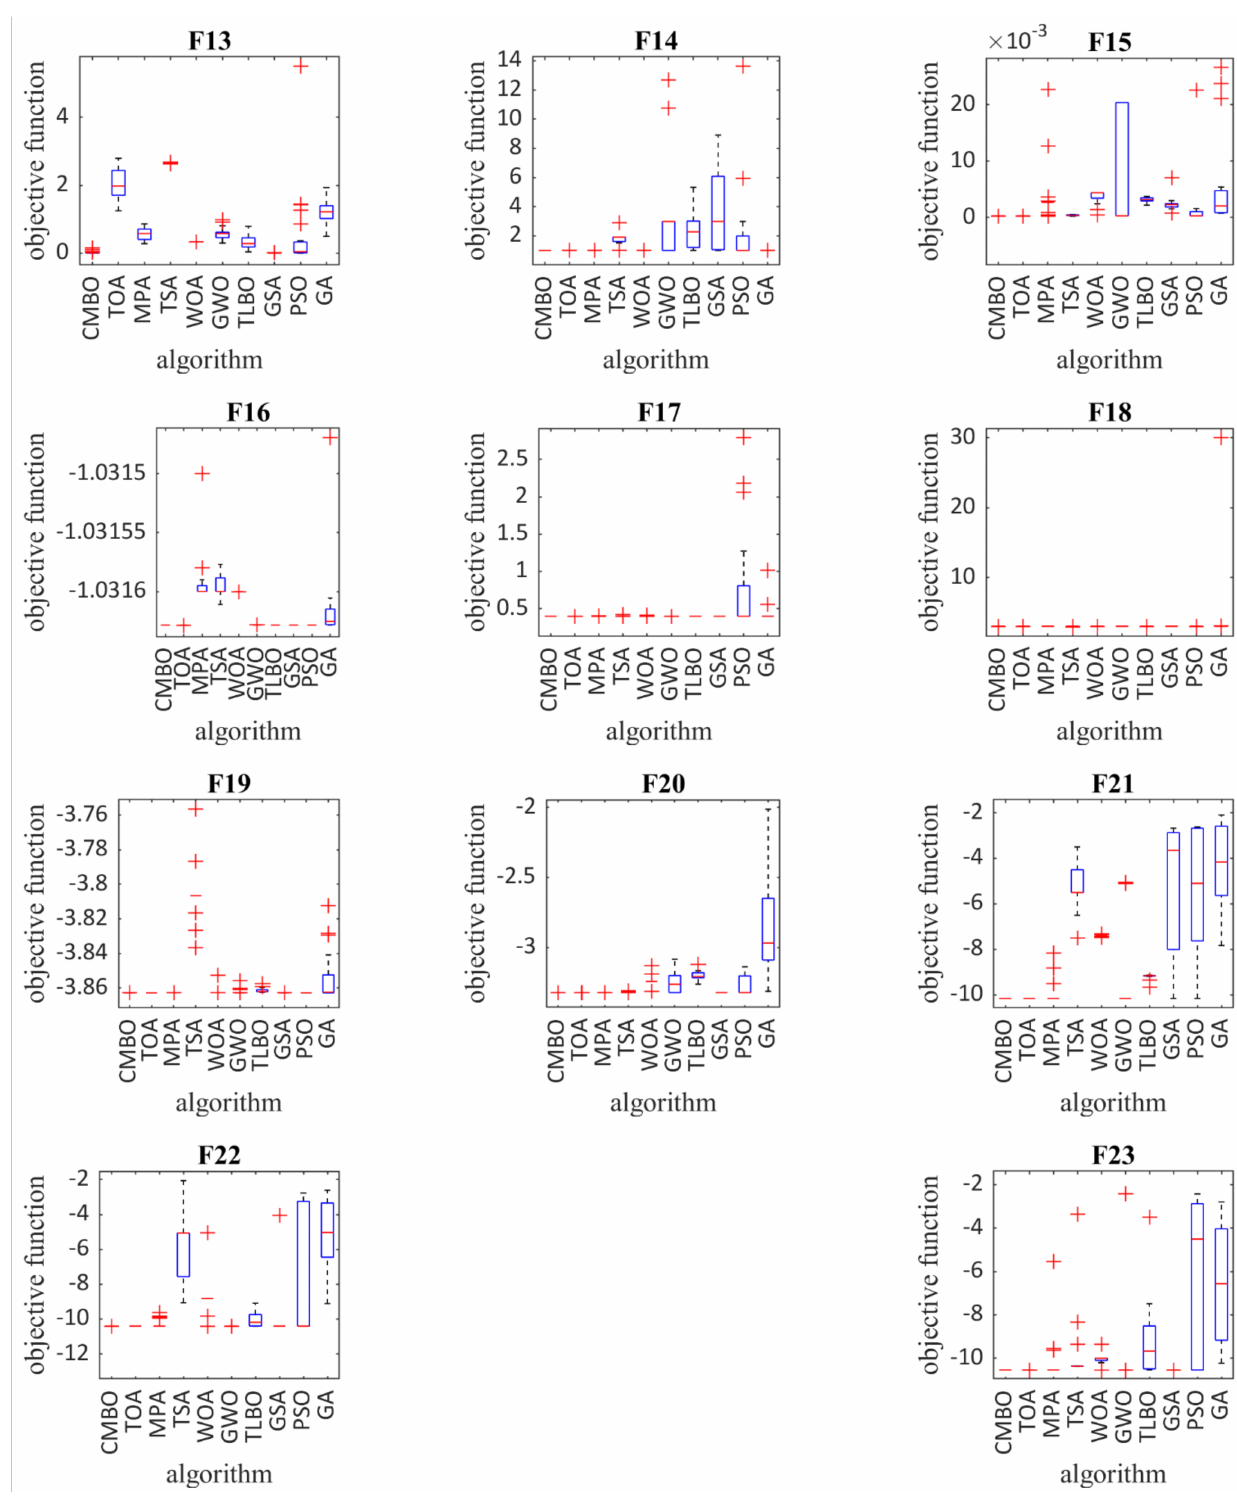
Figure 2. Boxplot of composition objective functions results for different optimization